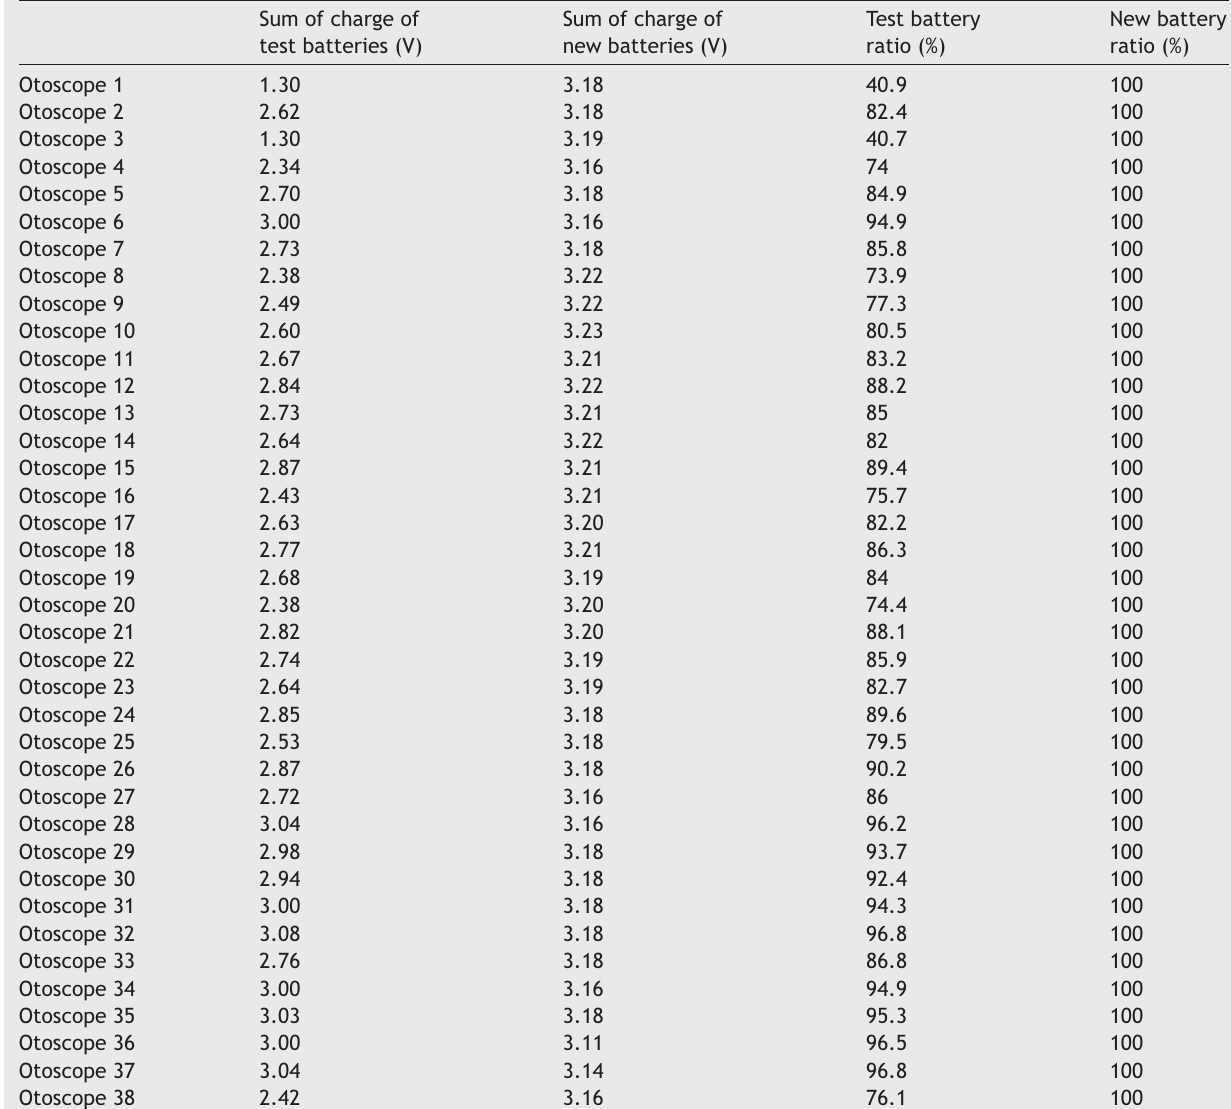
Full battery charge and test battery ratio in relation to the new batteries of each otoscope. Sum of charge